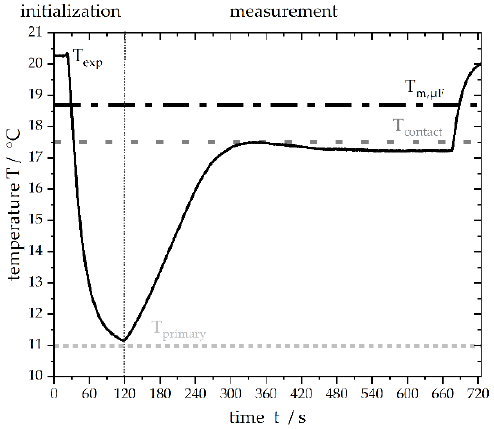
Figure 3. Temperature profile of the microfluidic chip 𝑇 (cid:3032)(cid:3051)(cid:3043) over time measured by the incorporated temperature sensor. After initiating spontaneous, primary nucleation at a subcooling of Δ𝑇 (cid:2869) = 𝑇 (cid:3040),µ(cid:3007) (cid:3398) 𝑇 (cid:3043)(cid:3045)(cid:3036)(cid:3040)(cid:3028)(cid:3045)(cid:3052) = 7.6 K , the temperature was set to a subcooling of Δ𝑇 (cid:2870) = 𝑇 (cid:3040),µ(cid:3007) (cid:3398) 𝑇 (cid:3030)(cid:3042)(cid:3041)(cid:3047)(cid:3028)(cid:3030)(cid:3047) = 1.1